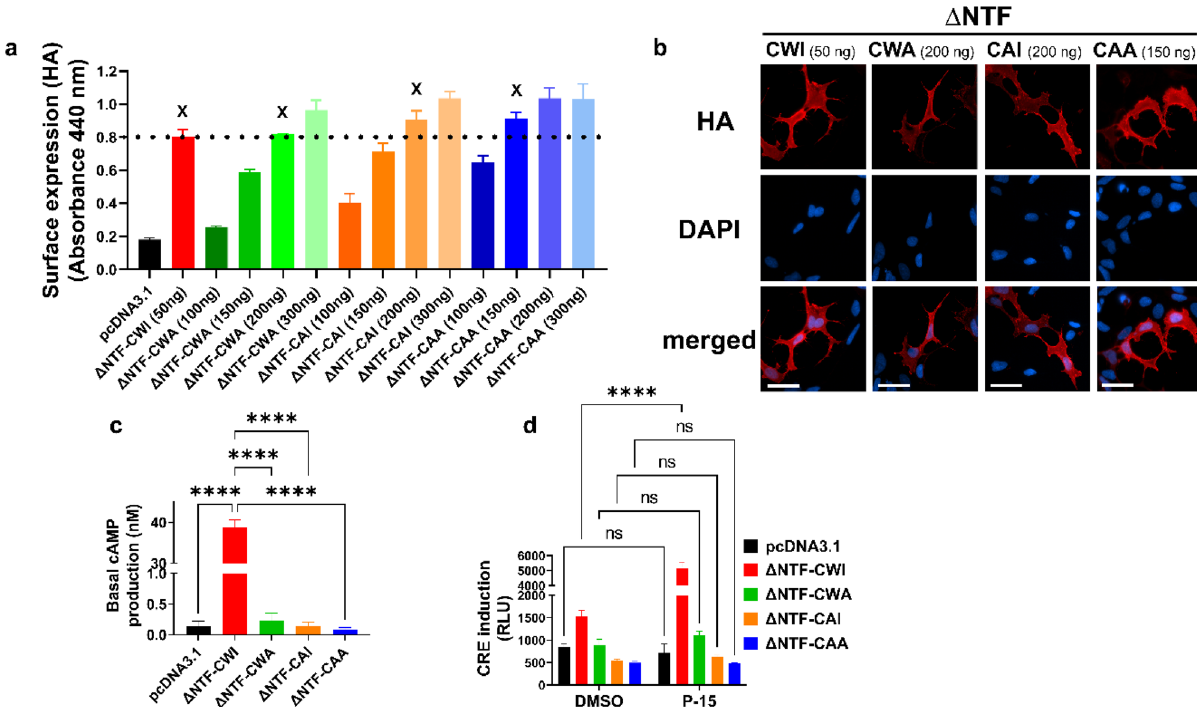
Figure 6. ECL2 is essential for the constitutive activity of NTF-truncated ADGRG2. ( a ) HEK cells were transfected with one dose of ∆NTF-CWI (50 ng) and different doses of mutant ∆NTF plasmids. Cell surface expression of receptors was determined by ELISA using an antibody against the N-terminal HA-tag in non- permeabilized conditions. X denotes the amount of mutant plasmids that resulted in comparable surface expression as 50 ng ∆NTF-CWI plasmid. Data are mean ± S.E.M from a representative experiment out of 3 independent experiments performed in triplicate. ( b ) Cell surface expression of receptors, after transfection with the adjusted doses of plasmids, was determined by immunofluorescence imaging using an antibody against the N-terminal HA-tag in non-permeabilized conditions. Nuclear counterstaining with DAPI. Representative images from 3 independent experiments are shown (scale bars: 20 µm). ( c ) Cells were transfected with adjusted doses of either ∆NTF-CWI or mutant plasmids and pcDNA3.1 as control. Basal cAMP production was measured after overnight incubation with 0.5 mM IBMX in starvation media in an HTRF assay. cAMP production in nM is presented as mean ± S.E.M from a representative experiment out of 3 independent experiments performed in duplicate. Data were compared with ∆NTF-CWI with one-Way ANOVA with Dunnett’s test. ****P < 0.0001. ( d ) Cells were transfected with adjusted doses of either ∆NTF-CWI or mutant plasmids along with CRE-Luc plasmid. After an overnight of serum starvation, cells were activated with either vehicle (DMSO) or 100 µM of P-15 for 5 h. Luciferase induction was measured in a luminescence-based assay. Relative light units (RLU) recorded in a luminometer are mean ± S.E.M from a representative experiment from 3 independent experiments performed in triplicate. Data were compared between vehicle and P-15 for each plasmid with two-Way ANOVA with Sidak’s multiple comparison test. ****P < 0.0001; ns: not